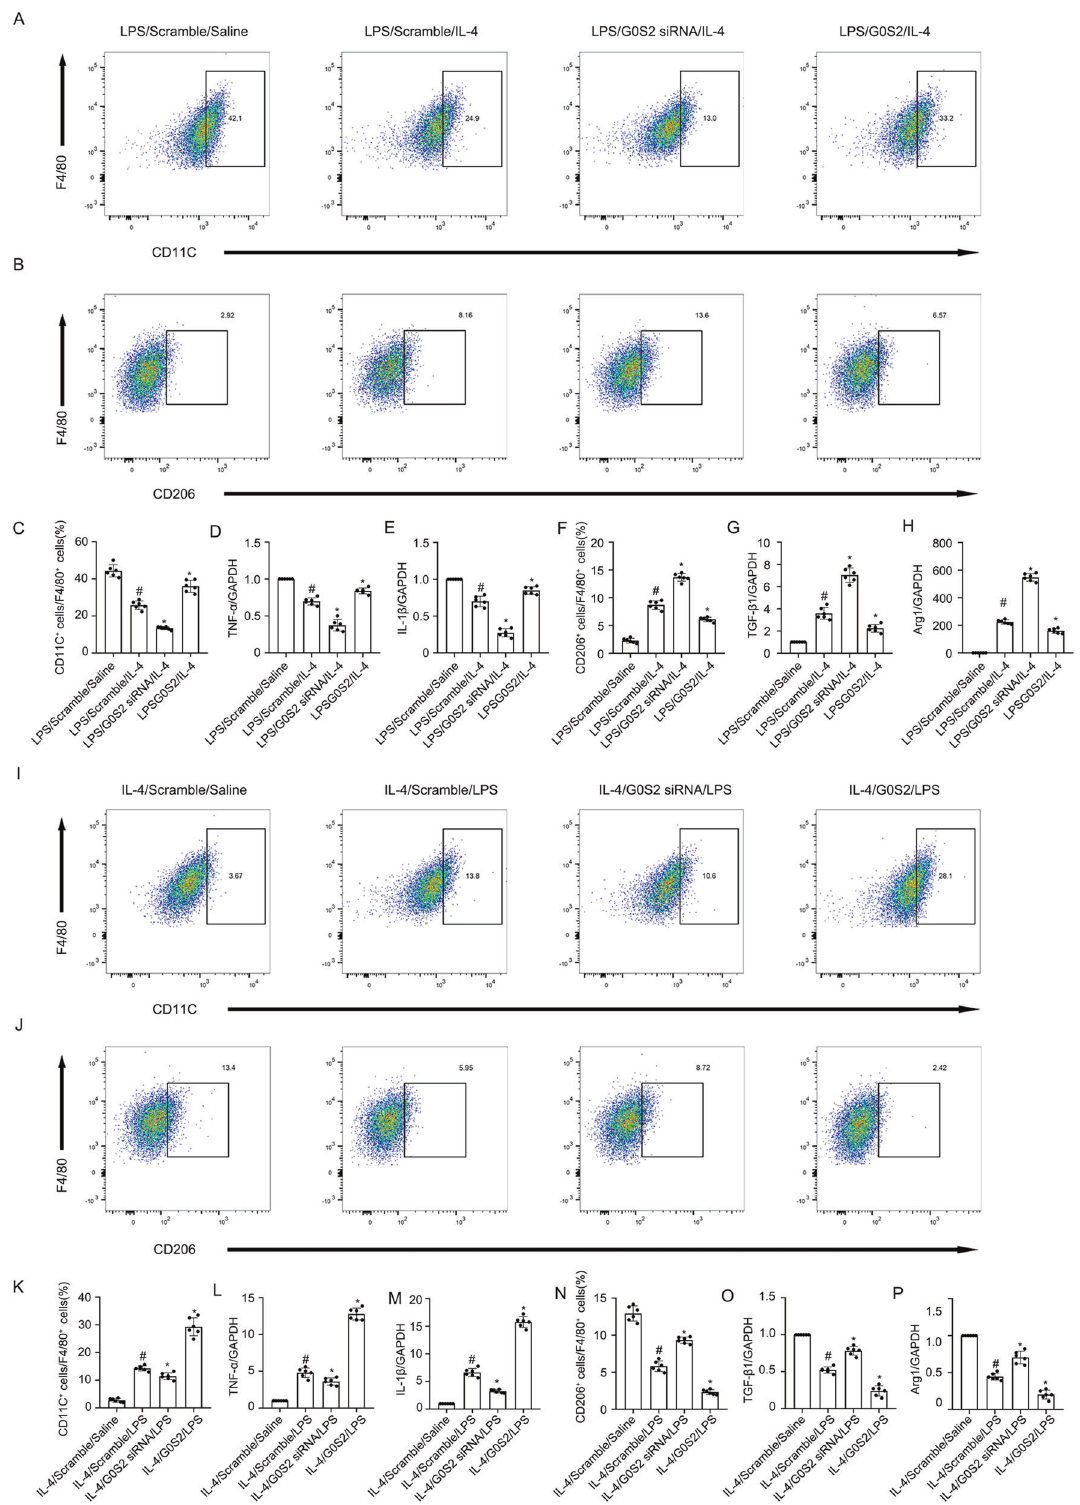
Fig. 6 G0S2 promoted transition of M2 to M1. RAW264.7 macrophage cells were transfected with G0S2 siRNA or G0S2 plasmid plus with LPS 1 μ g/ml or IL-4 20 ng/ml treatment for 24 h. A , C , I , and K Representative FCM analysis the ration of M1 (CD11C + cells vs. F4/80 cells). B , F , J , and N Representative FCM analysis the ration of M2 (CD206 + cells vs. F4/80 cells). D and L The expression levels of TNF- α were detected by real-time qPCR. E and M The expression levels of IL-1 β were detected by real-time qPCR. G and O The expression levels of TGF- β 1 were detected by real-time qPCR. H and P The expression levels of Arg1 were detected by real-time qPCR. # P < 0.05 versus Scramble plus LPS or IL-4 group. Data are expressed as means ± sd ( n = 6). * P < 0.05 versus LPS and IL-4 group.